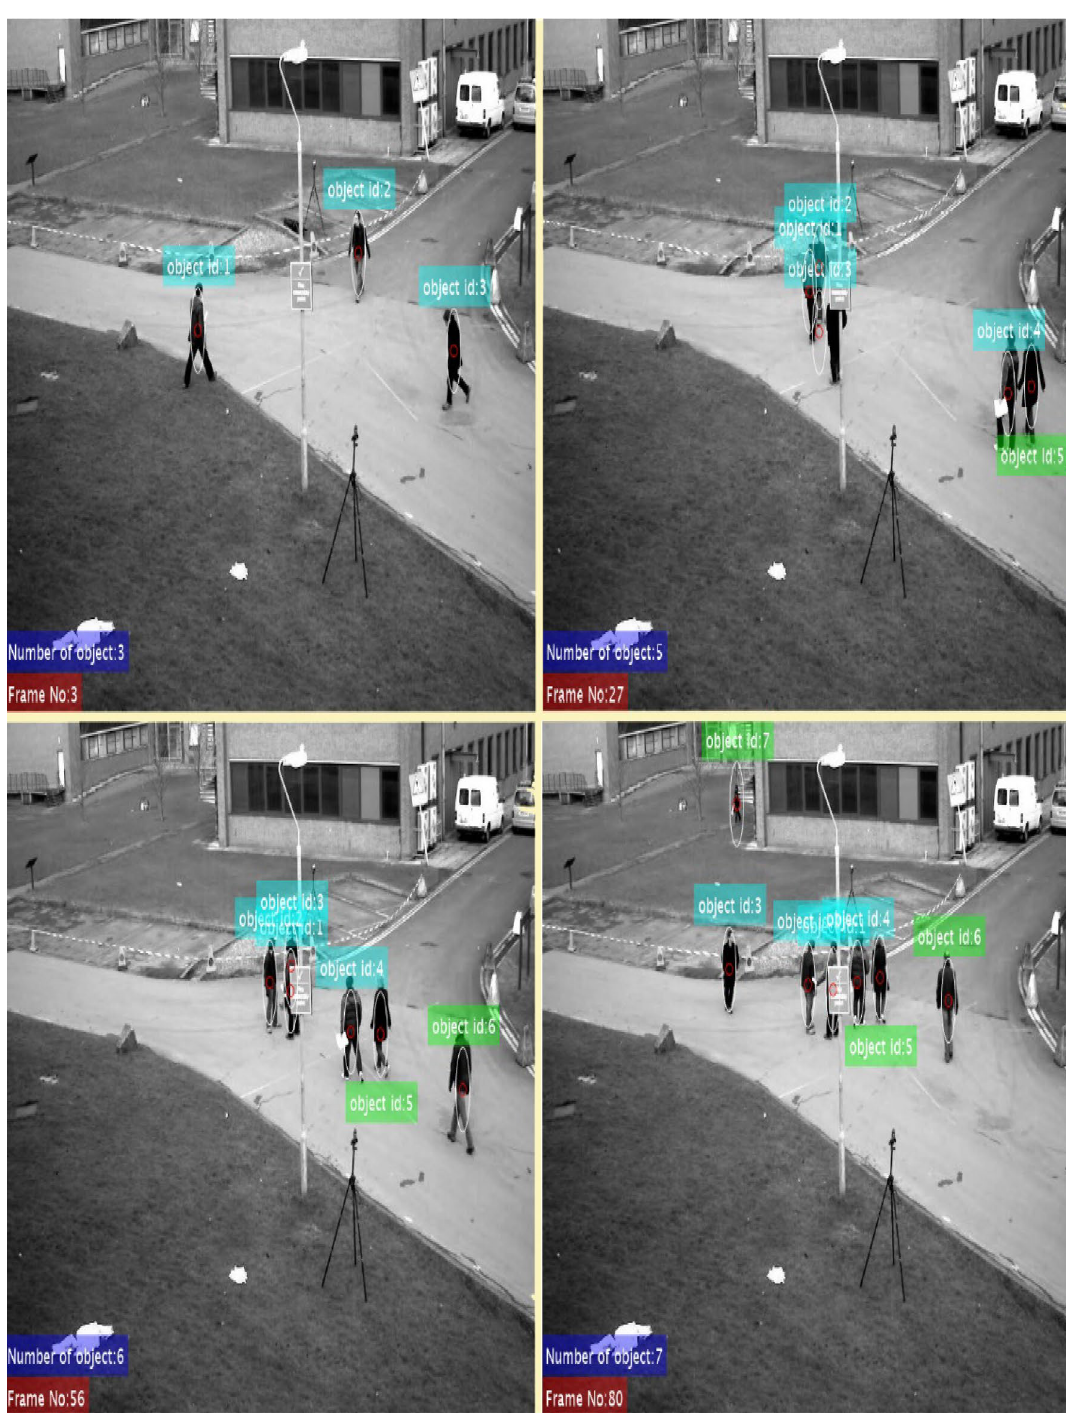
Fig. 8 JPDA filter Results in the proposed method for the frames numbered 3, 27, 56, 80 (up left to down right) of S2.L1 scenario of